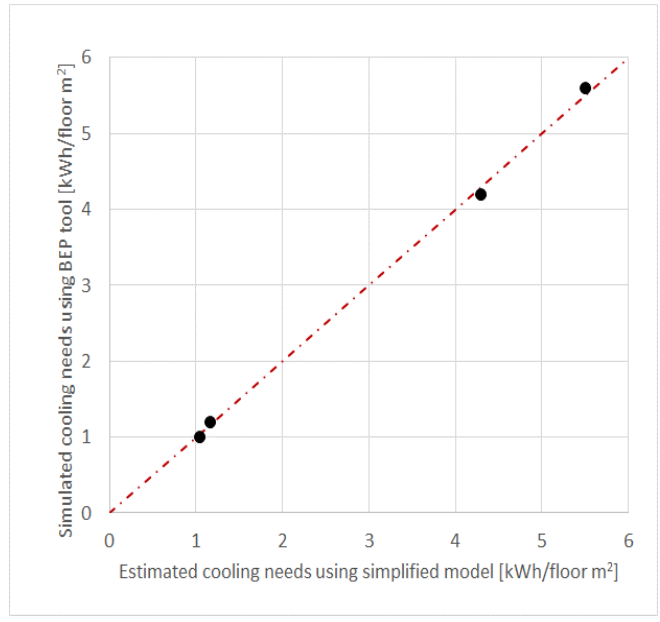
Figure 8. Comparison of the results of the building simulation and the application of the simplified model.